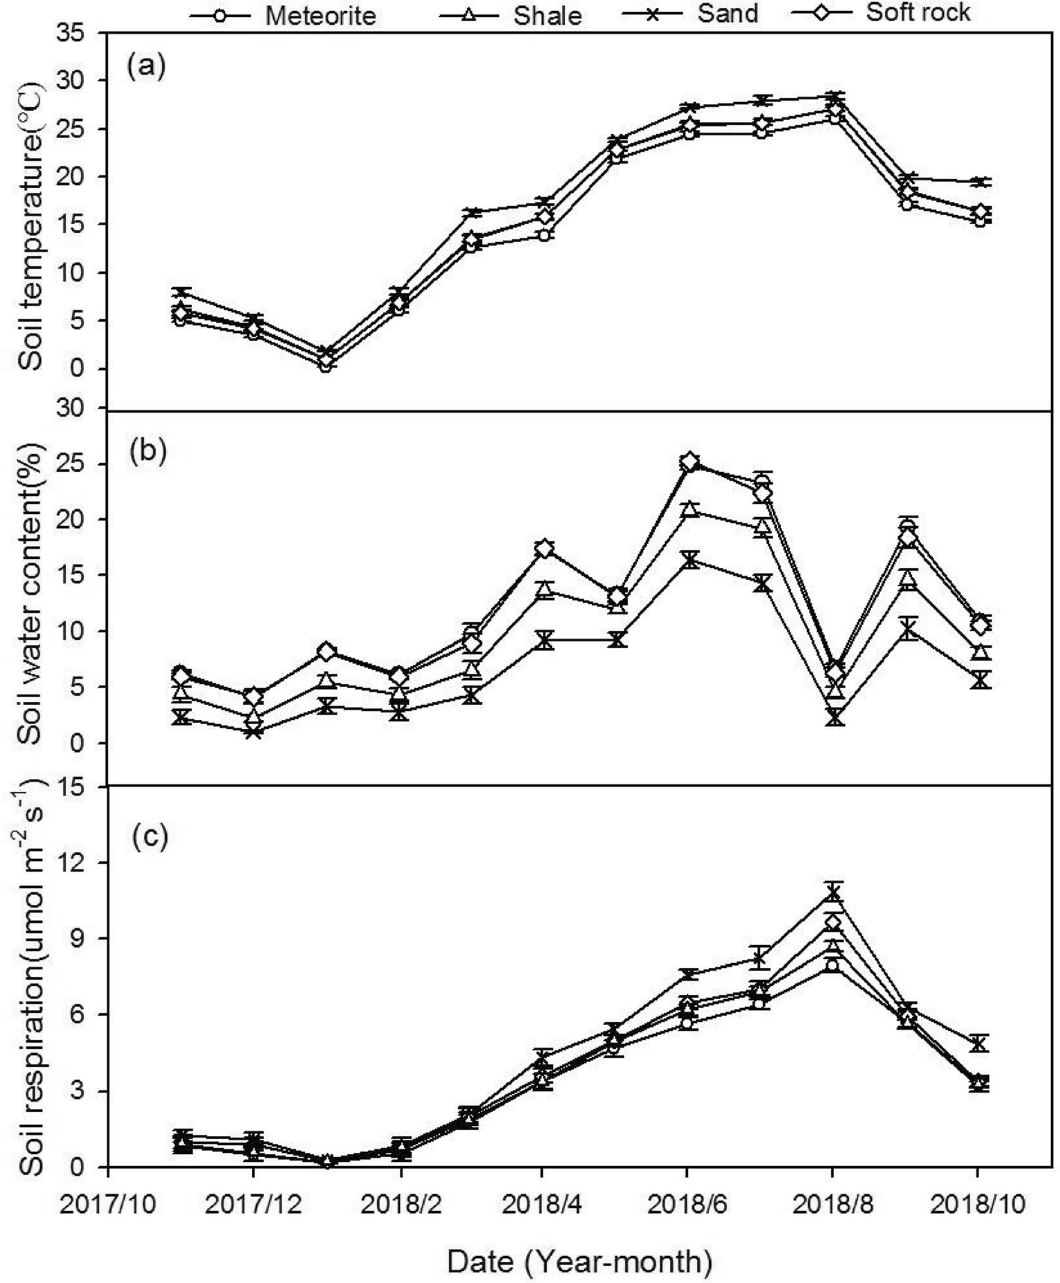
Figure 1. The seasonal change trend of temperature ( a ), volumetric water content ( b ) and respiration rate ( c ) of the four reconstructed